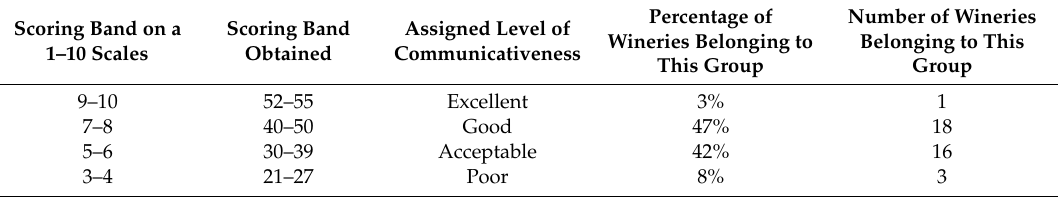
Table 6. Evaluation of websites of wineries in Mount Etna made by focus group